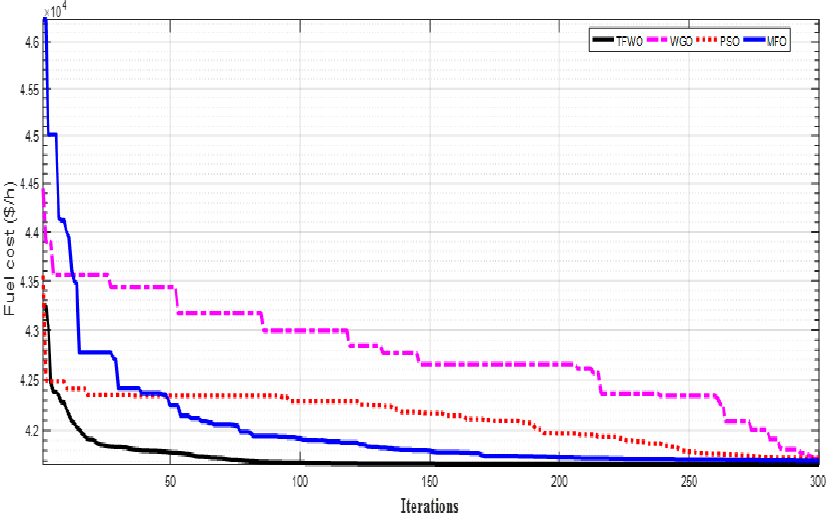
Figure 4. Convergence rates in Case 15 (fuel cost) using different optimizers.